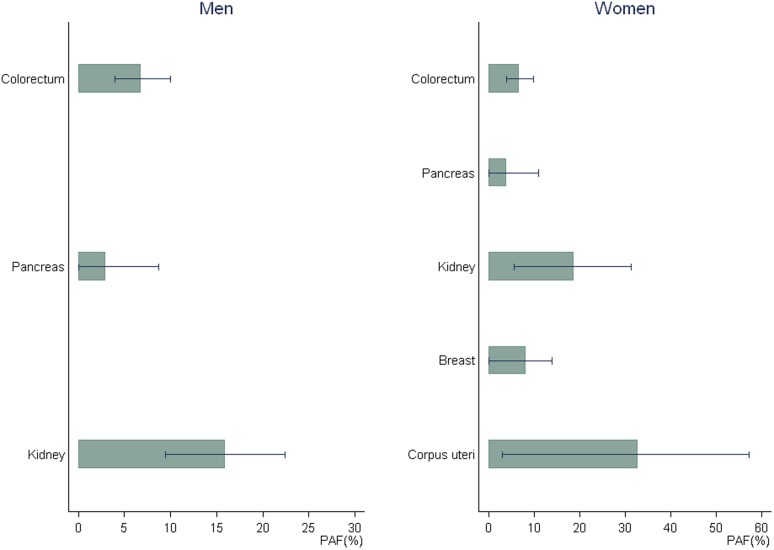
Sensitivity analysis on the estimation of population-attributable fractions for obesity using the lower and upper bounds of 95% confidence intervals of relative risks.